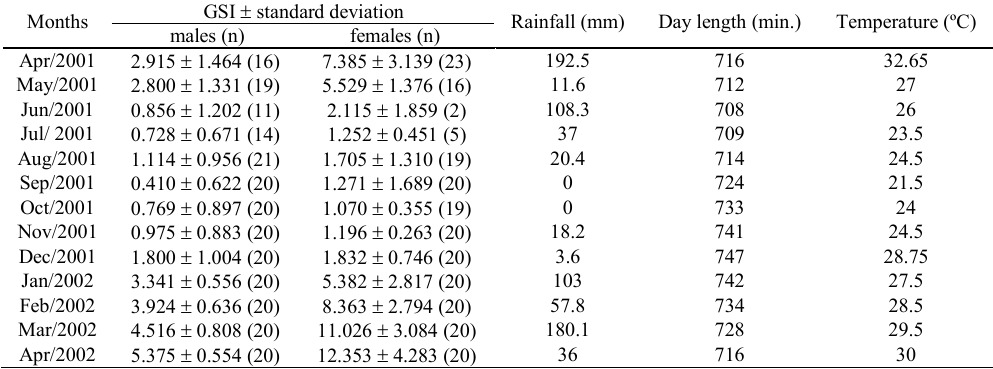
Table 1. Monthly variation of the means of the gonadossomatic index (GSI) (± standard deviation) for males and females of